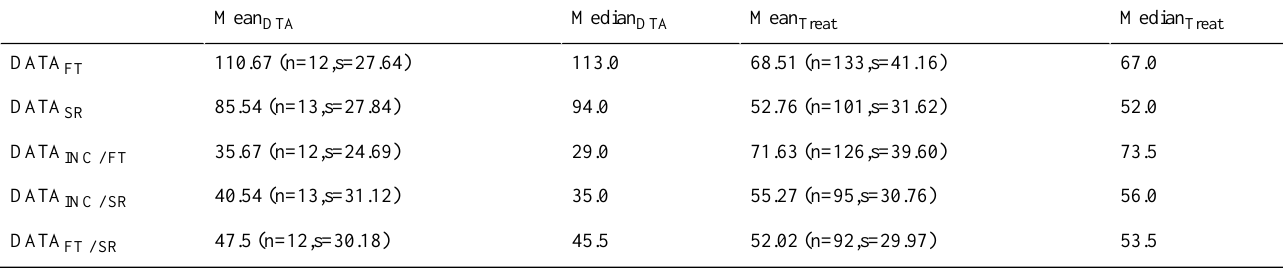
Table 6. Summary of ranked data for collected statistics.